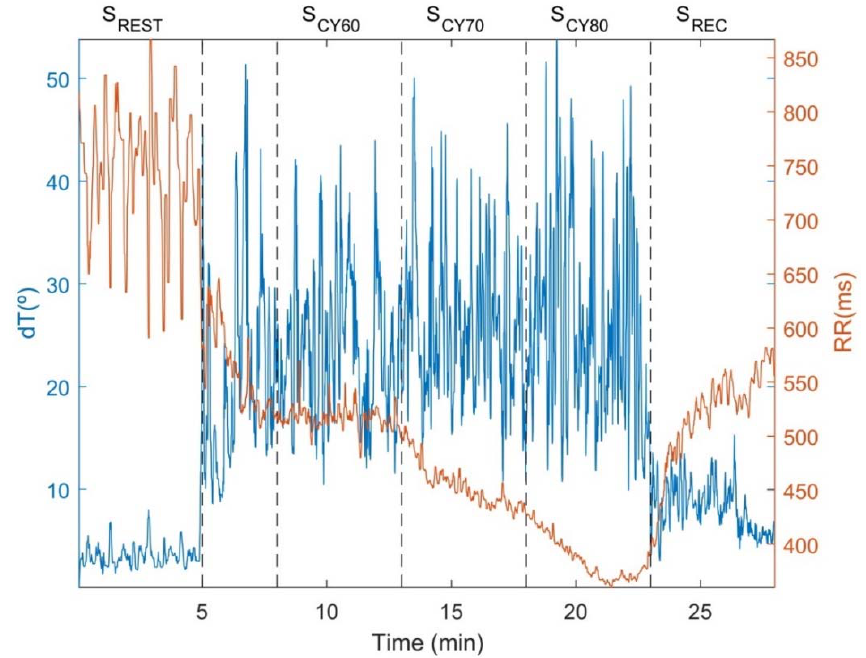
Figure 2. Example of the dT angle and RR interval time series for one subject throughout the entire test. Dotted lines separate the different test segments: resting (S REST ), cycling (S CY ) and recovery (S REC ). S CY was divided into three stages corresponding to 60, 70 and 80% of estimated HR max , denoted as S CY60 , S CY70 and S CY80 , respectively.